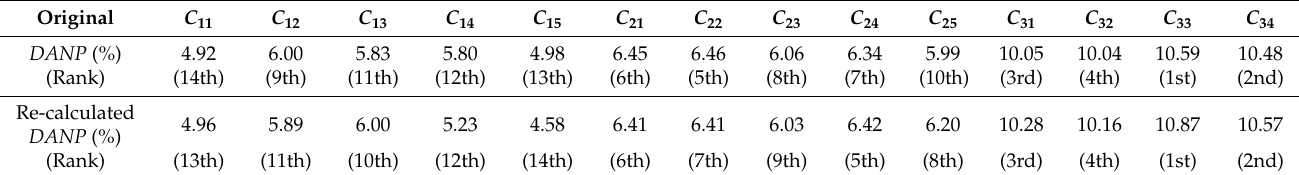
Table 9. Comparison of the original DANP weights and the re-calculated (experience-weighted)